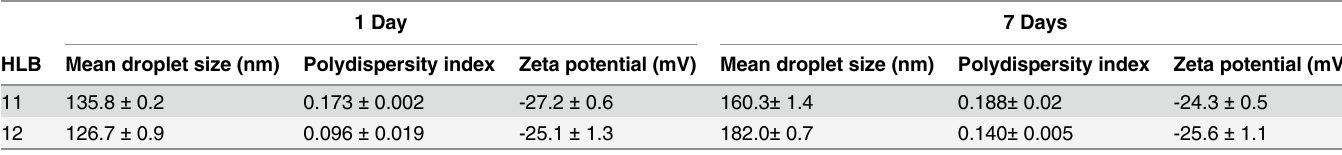
Table 1. Mean droplet size, polydispersity index and zeta potential during of emulsions prepared during rHLB determination of P . emarginatus